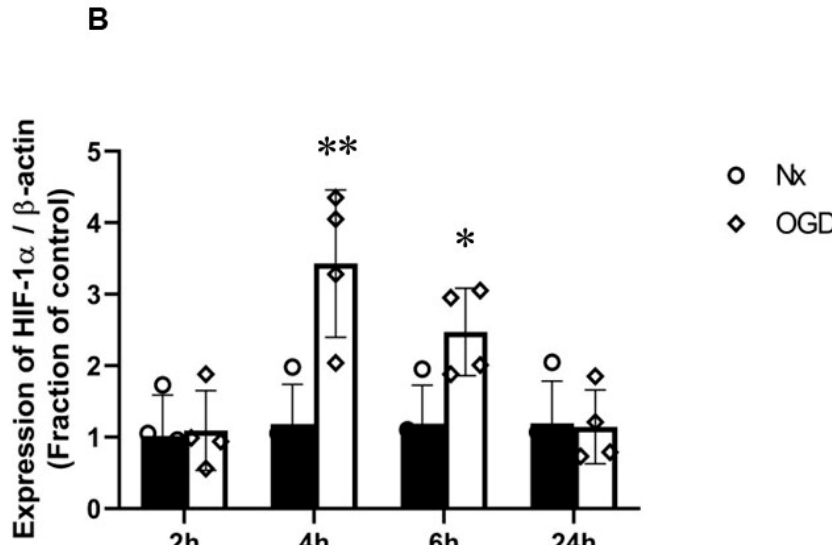
Figure 4. HIF-1 α protein stabilisation by oxygen–glucose deprivation (OGD) in PC12 cells. ( A ) Representative Western blots of HIF-1 α and corresponding β -actin of cells exposed to 2, 4, 6, and 24 h of OGD. The protein levels were quantified by densitometric analysis using Image J. Values were normalised to β -actin and corresponding Nx control (Figure S1). ( B ) Graph ( n = 4) showing the normalised HIF-1 α level measured after 2, 4, 6, and 24 h OGD. There were significantly higher HIF-1 α / β -actin ratios with OGD (4 and 6 h) treatments compared to Nx controls. Error bars represent ± S.D. * Indicates p < 0.05, ** p < 0.05, against Nx controls.